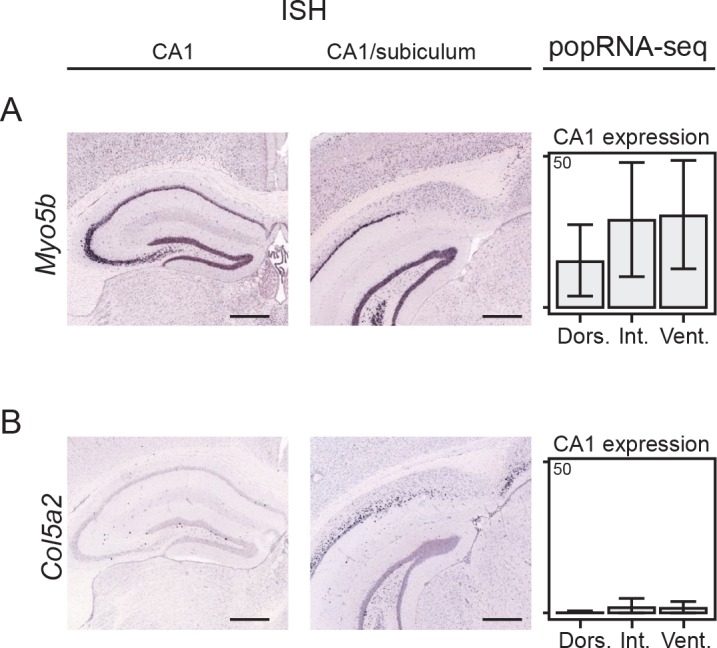
Expression of Myo5b is associated with CA1 pyramidal cells.(A) Left: ISH showing expression of Myo5b in anterior CA1 pyramidal cells. Middle: as at left, but with more posterior section showing CA1/subiculum boundary. Expression is restricted to the tightly packed pyramidal cell group only, consistent with CA1 expression. Right: expression from population-level RNA-seq in dorsal, intermediate, and ventral CA1 PCs. Units are FPKM (Fragments Per Kilobase of exon per Million reads), with data from Cembrowski et al., 2016b. Scale bars: 500 μm. (B) As in A, but for expression of Col5a2. This gene labels loosely packed cell bodies (putative subiculum) and lacks expression in CA1 cells. Scale bars: 500 μm.